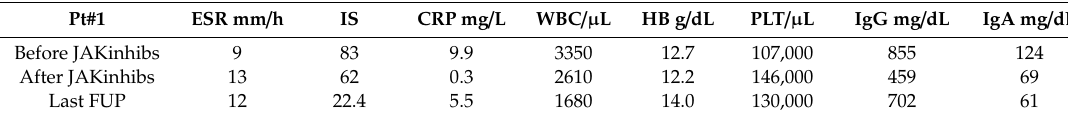
Table A1. Patient #1 laboratory findings.